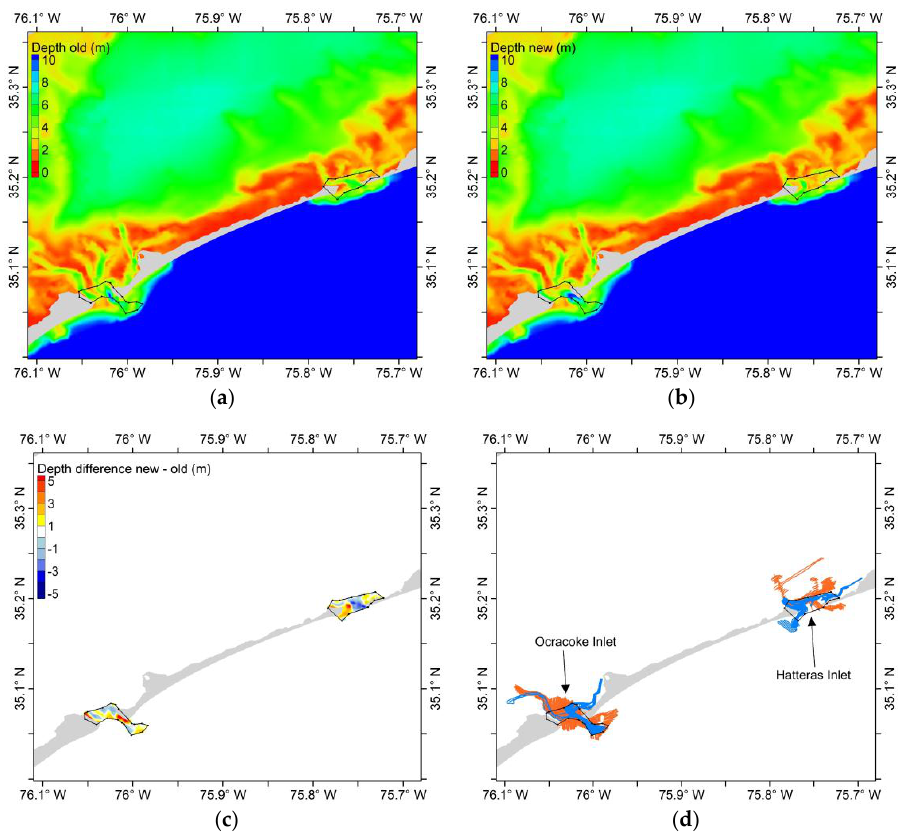
Figure 4. The morphological changes around Ocracoke Inlet and Hatteras Inlet: ( a ) the old-bathy grid depths; ( b ) the new-bathy grid depths; ( c ) the depth difference between the new-bathy grid and the old-bathy grid; ( d ) the original bathymetry sounding data points (orange: data in 1956 and 1962 around Ocracoke Inlet and data in 1935 around Hatteras Inlet; blue: data in 2013 around Ocracoke Inlet and data in 2014, 2015, and 2016 around Hatteras Inlet). The black dotted polygons delineate the area with changed bathymetry.